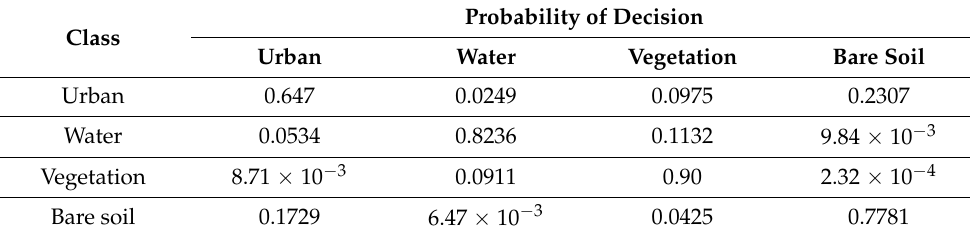
Table 12. Confusion matrix for the image compressed with DAT of depth 1 with MAD = 11.